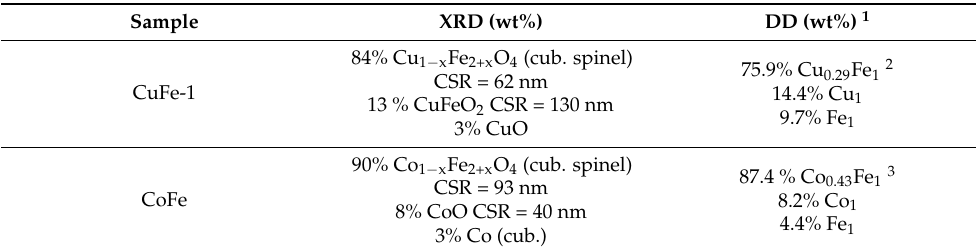
Table 1. The comparison the results of X-ray diffraction (XRD) method and differential dissolution (DD) for the samples of copper and cobalt ferrites prepared by combustion synthesis.